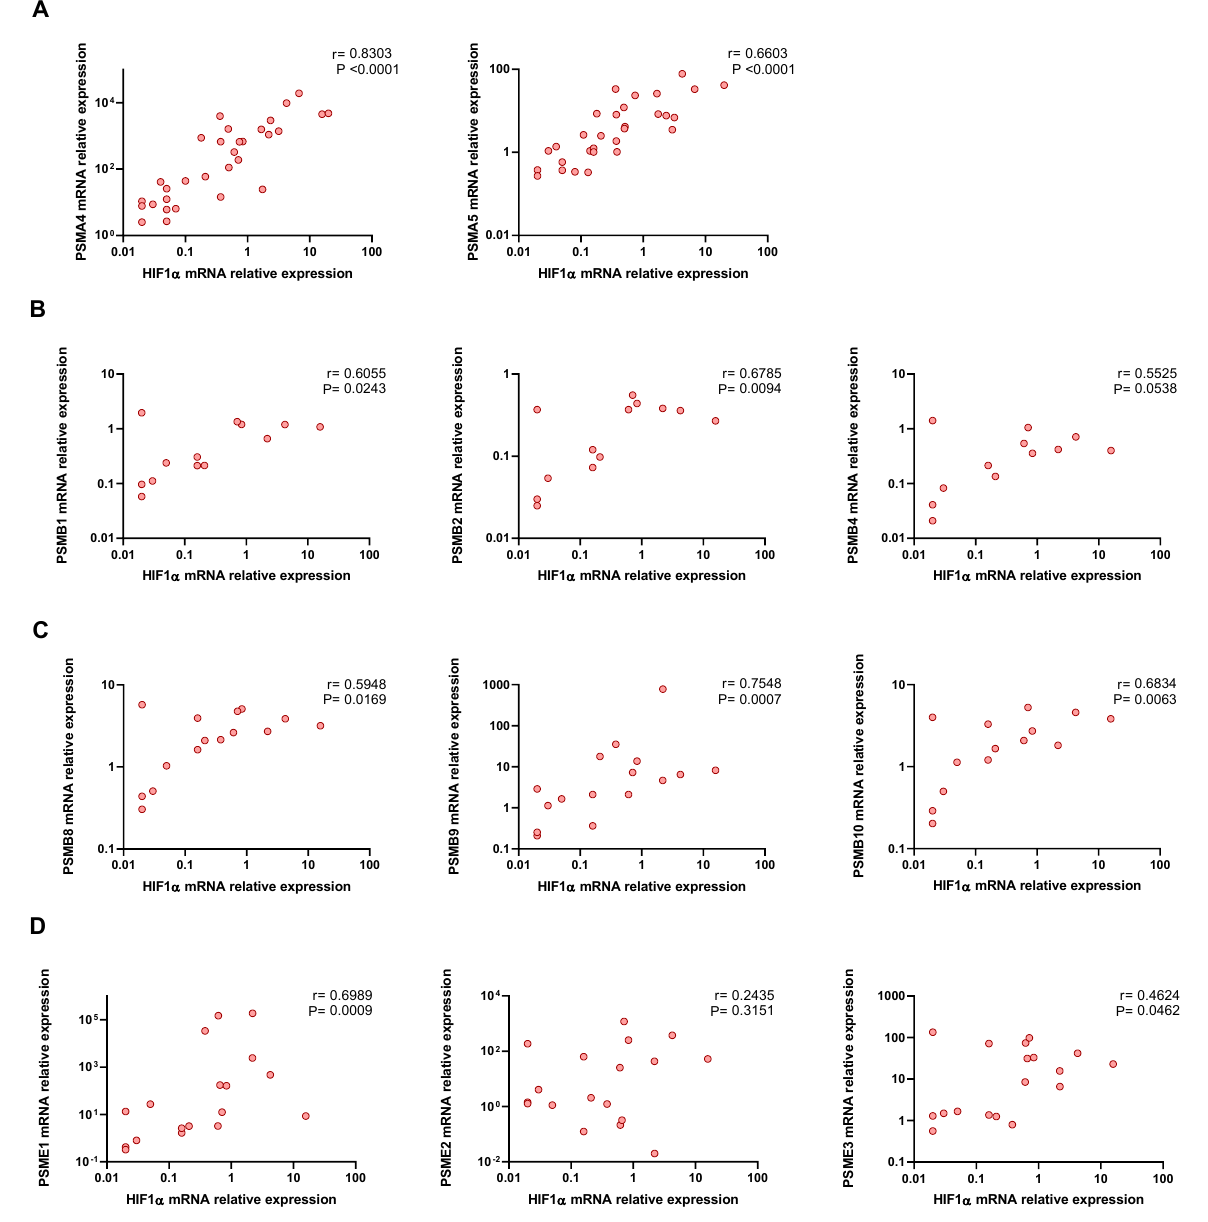
Figure 2. Hypoxia-inducible factor 1-alpha correlation with proteasome subunits. Correlation of hypoxia-inducible factor 1-alpha (HIF-1 α ) mRNA expression and mRNA expression of ( A ) 20S proteasome alpha ring subunits: PSMA4 ( n = 31), PSMA5 ( n = 32); ( B ) 20S proteasome beta ring non-catalytic subunits: PSMB1 ( n = 14), PSMB2 ( n = 14), PSMB4 ( n = 13); ( C ) 20S immunoproteasome beta ring catalytic subunits: PSMB8 ( n = 16), PSMB9 ( n = 17), PSMB10 ( n = 15); and ( D ) 11S proteasome subunits: PSME1 ( n = 19), PSME2 ( n = 19), PSME3 ( n = 19). Correlations were analysed using Spearman’s analysis. p -value and Spearman’s correlation coefficient ( ρ ) are shown. In order to verify the contribution of HIF1- α to the upregulation of proteasome subunits in COVID-19 patients, we exposed PBMCs from healthy volunteers to hypoxic conditions in combination with PX-478 (S-2-amino-3-[4V-N, N-bis (2-chloroethyl) ami- no]-phenyl propionic acid N-oxide dihydrochloride), which suppresses constitutive and hypoxia- induced levels of HIF1α (Figure S2 A). The mRNA levels from all of the pro- teasome subunits studied (unless PSMB5, PSMB6) increased under hypoxic condition,